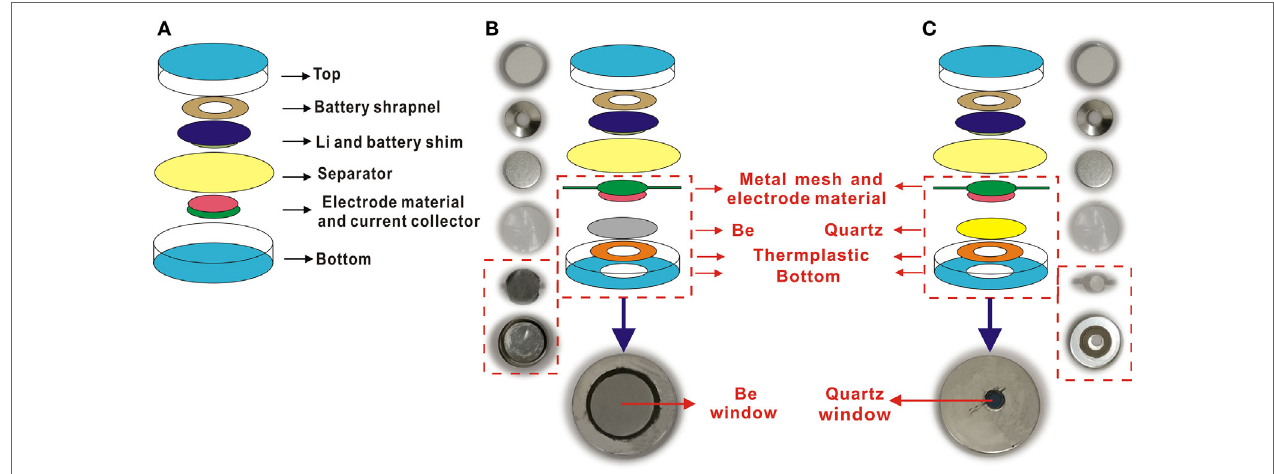
FigUre 1 | Structure diagrams and real photos of normal coin cell and in situ coin cell. (a) Normal coin cell. (B) In situ X-ray diffraction coin cell. (c) In situ Raman coin